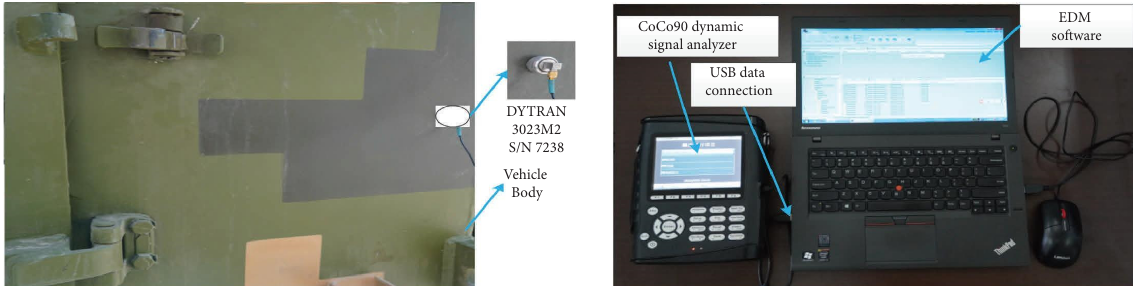
Figure 4: Sensor installation diagram and test